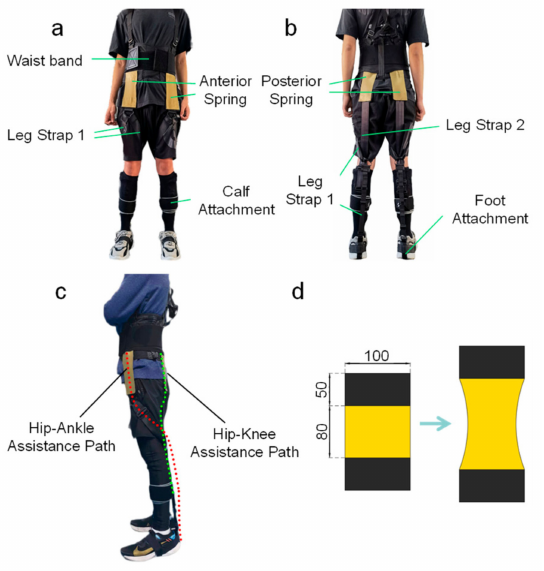
Figure 2. Overview of the soft exoskeleton. ( a ) Front and ( b ) rear view of the device; schematic diagram of the hip-ankle assistance path and the hip-knee assistance path; ( c ) schematic diagram of the geometry of the elastic elements placed anteriorly and posteriorly across the hip; ( d ) dimensions are in